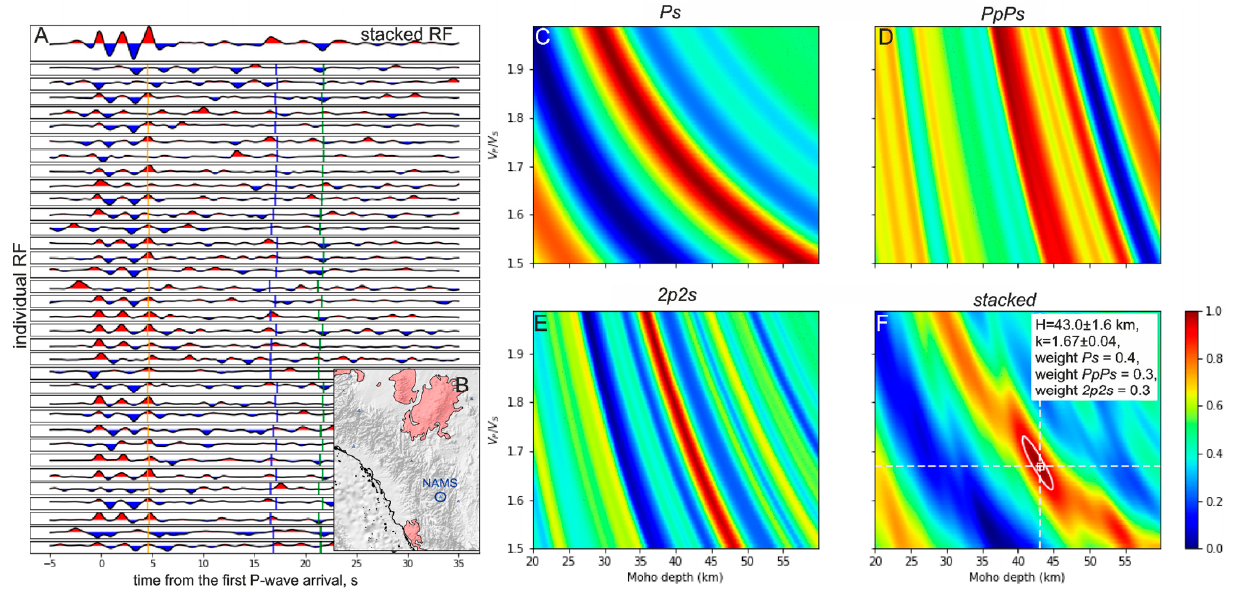
Figure 5. Results of the H-k stacking for the station NAMS located on the Arabian Shield far from the Red Sea coast. ( A ): Individual receiver functions (Q-component). The upper trace is the average of all traces. Red, blue, and green hatches mark the theoretical arrivals of the Ps , PpPs and 2p2s phases, respectively. ( B ). The location of the station on the map. ( C – E ): Grid search results for three individual phases Ps , PpPs and 2p2s . ( F ): Result of stacking of the results for all phases. The white dashed lines mark the best solution. The parameters of stacking and results for H and k determination are shown on the panel F.